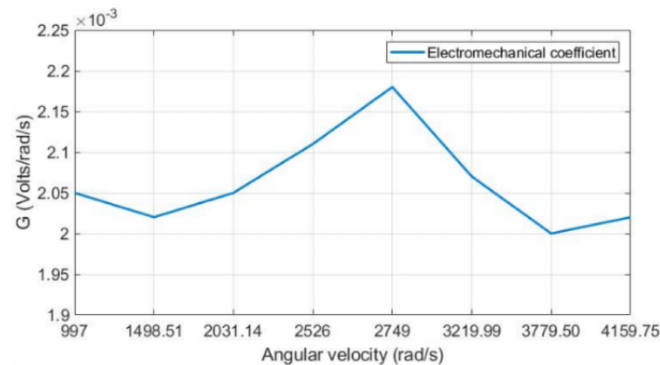
Figure 8. Electro-mechanical coe ffi cient for di ff erent air velocities.